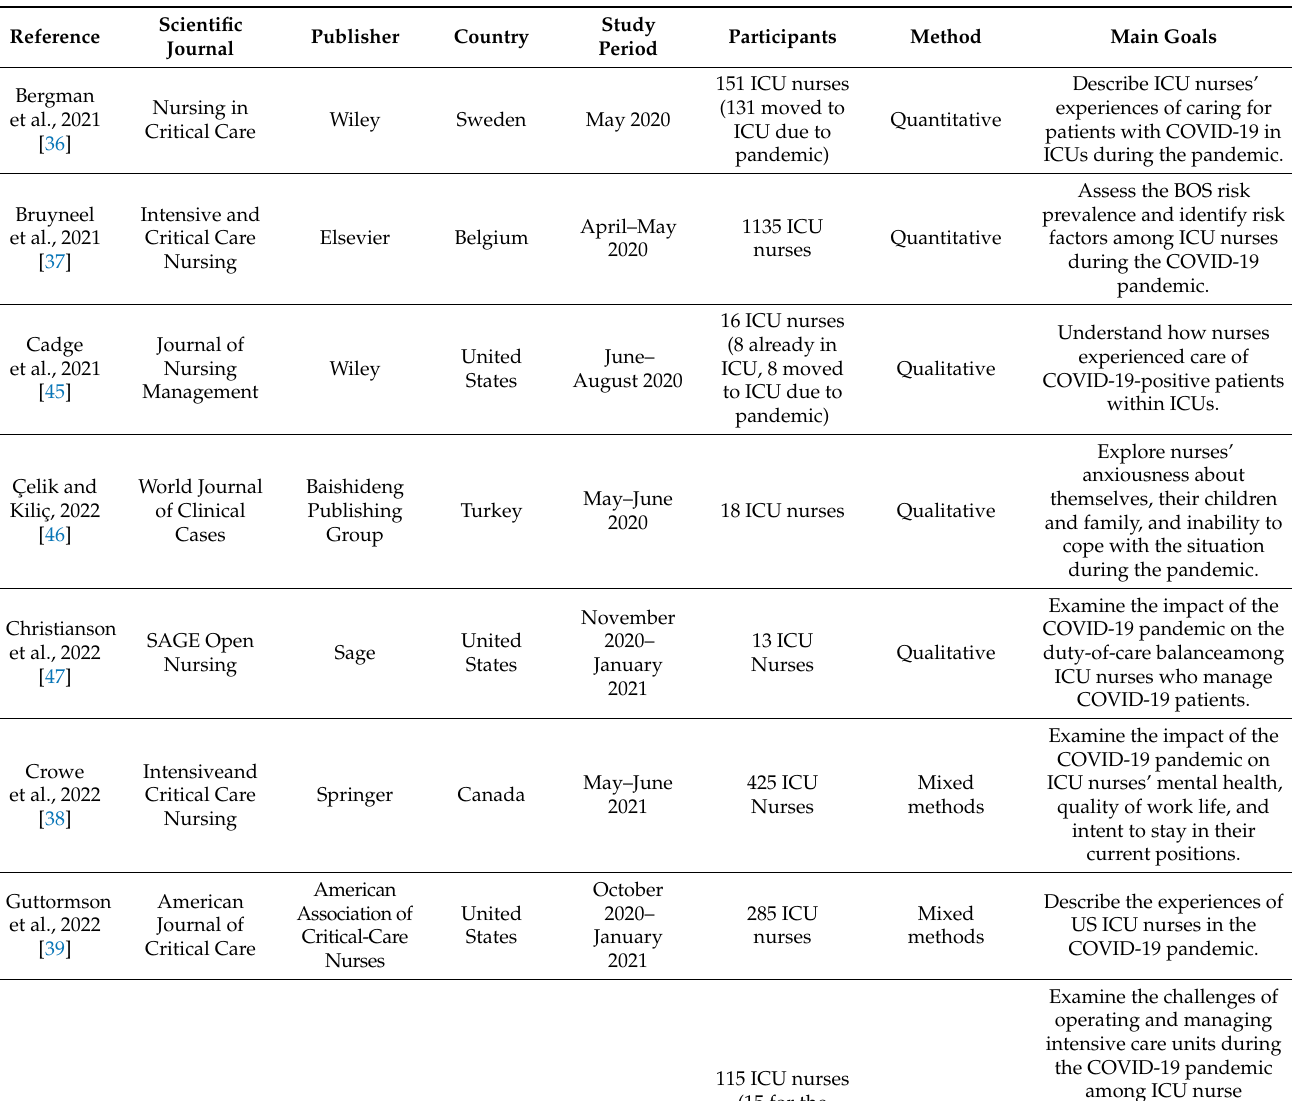
Table 3. Main characteristics of the reviewed